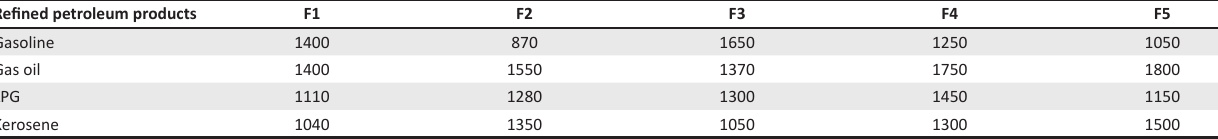
TABLE 7: Filling stations demand of refined petroleum products (m 3 ). Refined petroleum products